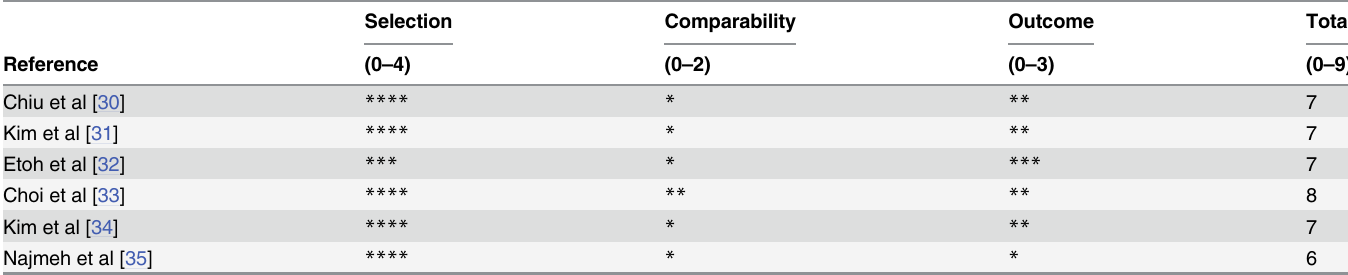
Table 3. Quality assessment of included